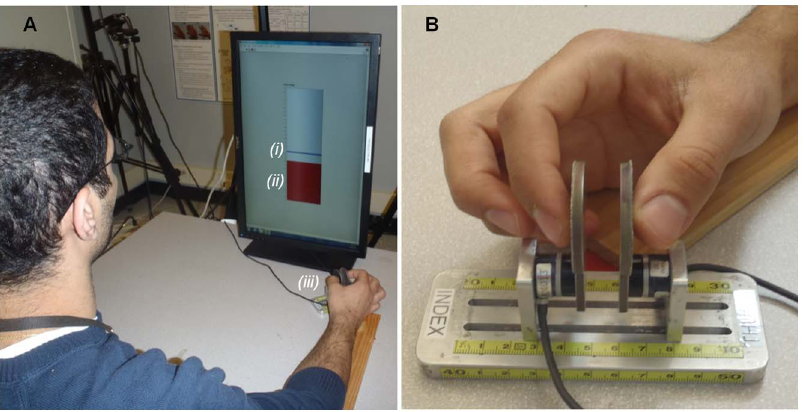
Figure 1 . Experimental setup for the pinch task. (A) A subject interfacing with the pinch apparatus while viewing the monitor for force feedback. (i) The horizontal line in the middle of the tank serves as the target line; (ii) the vertical bar indicates the real-time pinch force of the subject; and (iii) the pinch apparatus in the experiment. (B) Close-up of the typical pinching posture assumed while the digits are interfacing with the apparatus.